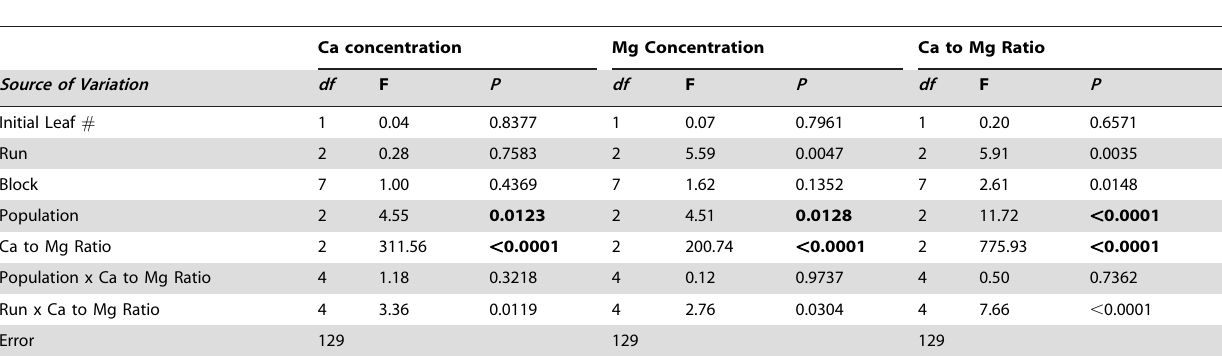
Table 4. ANOVA table for Ca, Mg, and Ca to Mg ratio in the rosettes of three A. l. ssp. lyrata populations exposed to different substrate Ca to Mg ratios.